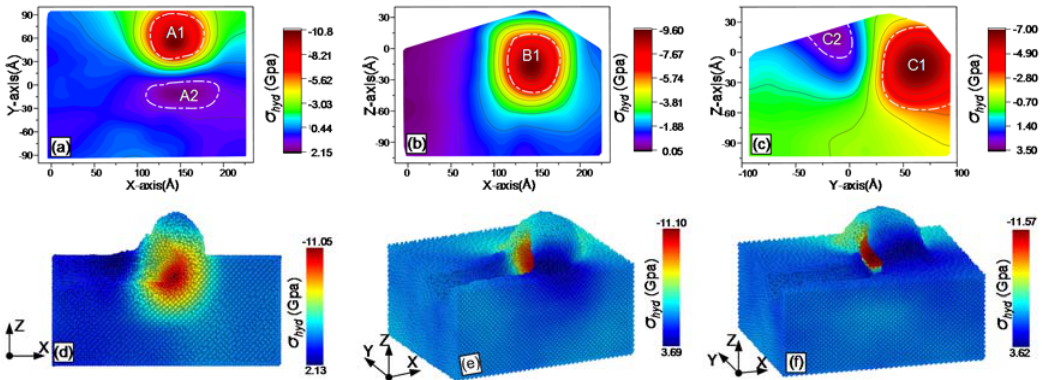
Figure 8. Snapshots of von Mises stress σ von after the atomic ‐ scale curve grinding: ( a ) on X–Y plane; ( b ) on X–Z plane; ( c ) on Y–Z planes; ( d ) at the front point of the arc, ( e ) at the rear of the arc; and ( f ) at the end of the tool.